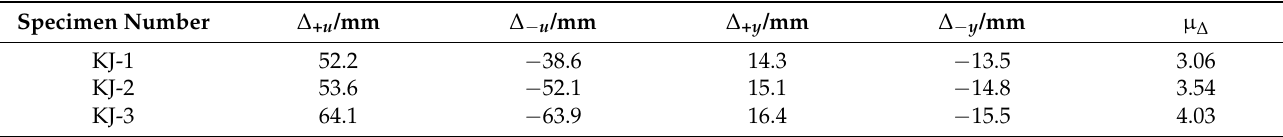
Table 6. Displacement ductility values for the frames.